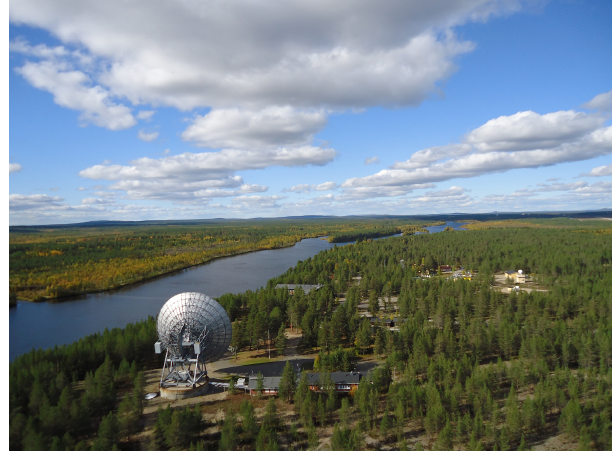
Figure 14. The Sodankylä Geophysical Observatory, the Meteo- rological Research Institute of Lapland, the buildings belonging to the EISCAT compound and the EISCAT antenna in the front, SGO’s buildings further down, and the river Kitinen is shown on the left- hand side (photo by Timo